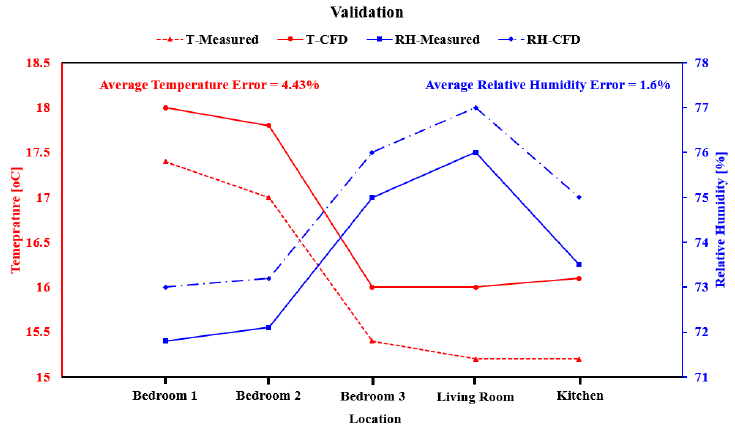
Figure 4. Computational model validation for the measured temperature and relative humidity.